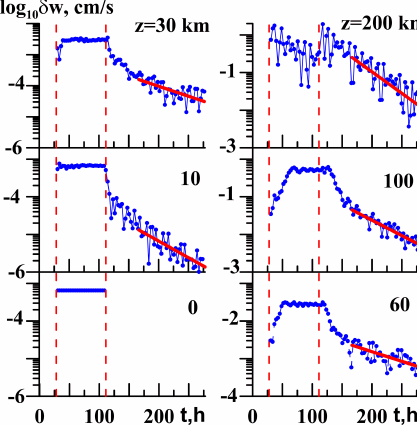
Figure 3. Same as Fig. 2, but for the sharp wave source activation.